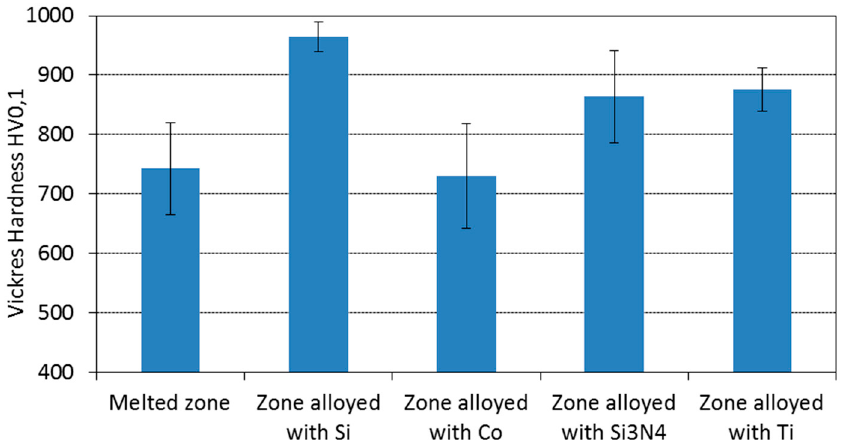
Figure 18. Average hardness of the melted and alloyed zones after laser alloying with silicon, cobalt, silicon nitride, and